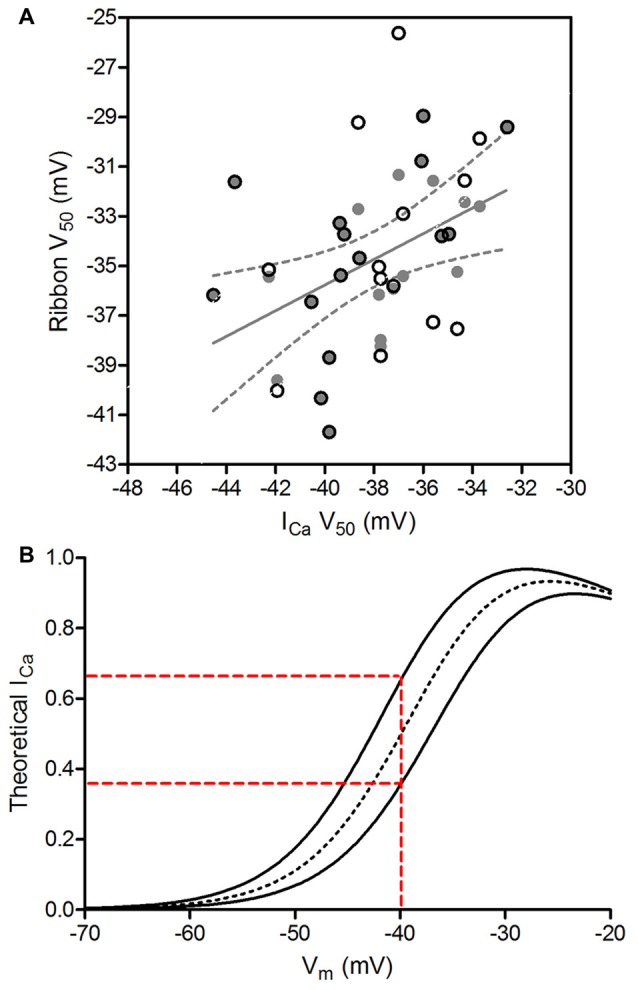
Genuine ribbon-to-ribbon variability can be functionally relevant. (A) V50 values of ribbon Ca2+ signals were not strongly correlated with V50 values of whole cell ICa from the cones in which they were measured. The strongest correlation was obtained by using one data point per cone and selecting the V50 values for ribbon Ca2+ signals that were most similar to V50 for ICa in the same cone (gray circles). The graph shows the linear regression fit to this subset of data along with the 95% confidence interval (R2 = 0.228, slope = 0.517 ± 0.187 [SEM]; p = 0.01, F-test for non-zero slope). Open circles show the single ribbons from each cone with V50 values that were least similar to V50 for ICa in the same cone. (B) Ribbons can exhibit functionally relevant differences in Ca2+ influx. The dotted black line simulates a ribbon with the average ICa parameters from our analysis (V50 = −38.1 mV, slope = 4.9, Imax = 0.0251). The two solid lines show curves differing in V50 by ±1 SD (V50 = −40.6 and −35.6 mV). The more positively-activating ribbon would experience >45% less Ca2+ influx than the more negatively-activating ribbon at a cone membrane potential of −40 mV (red dashed lines). Alternatively, the more negatively-activating ribbon would experience >80% more influx than the more positively-activating ribbon at −40 mV.